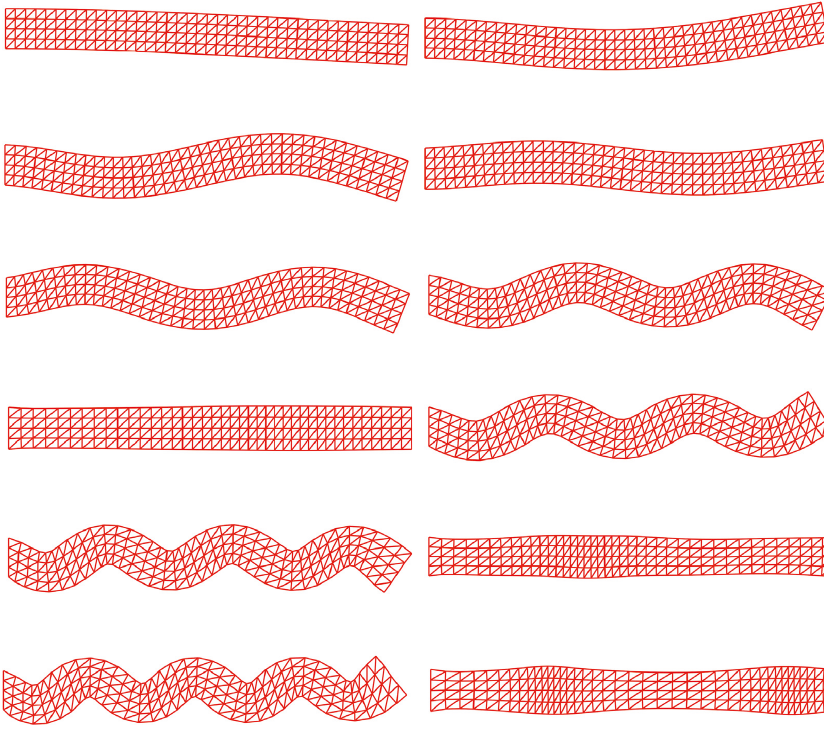
Figure 23: First 12 modes of the cantilever beam by GS-FEM.